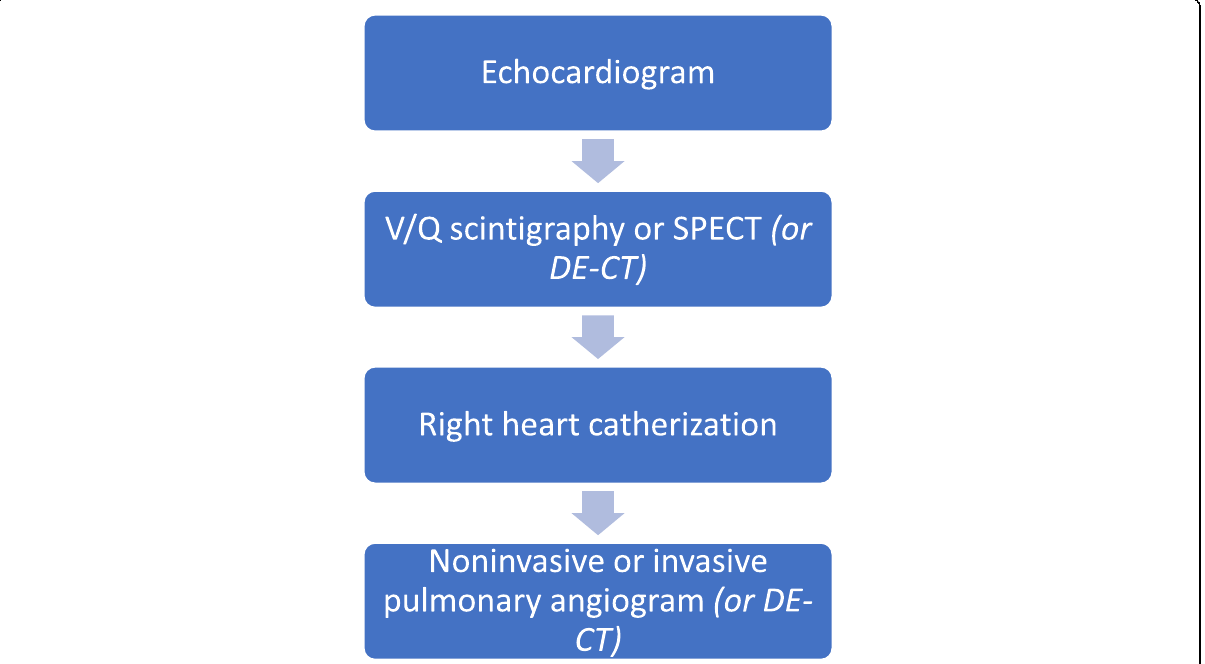
Fig. 22 Imaging algorithm in CTEPH. Diagram demonstrates an algorithm for the imaging in patients with suspected CTEPH